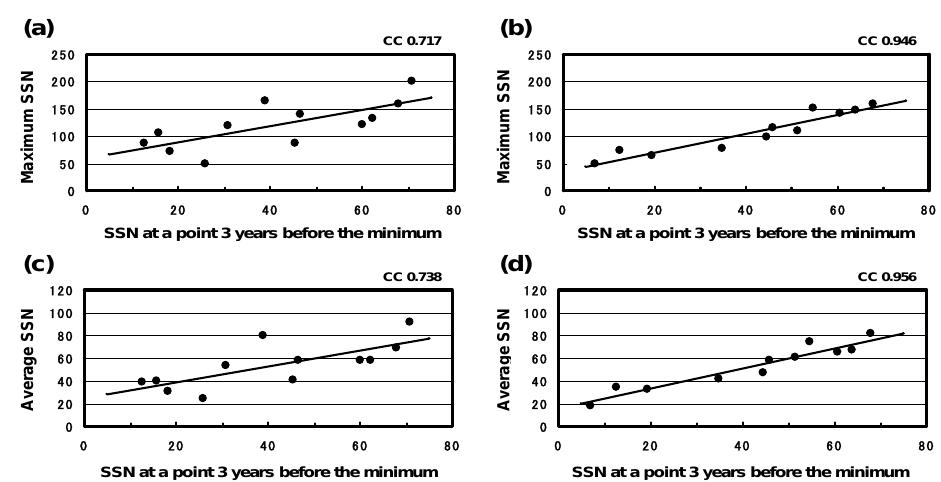
Figure 1. (a) Scatterplot of maximum SSN versus SSN 3 years before the minimum for odd-numbered cycles. (b) Same as panel (a) but for even-numbered cycles. The correlation coefficient and its lower and upper limits of the 95% confidence interval are 0.717, 0.243 and 0.921 for the former case, while those for the latter case are 0.946, 0.800 and 0.986, respectively. (c) Scatterplot of average SSN versus SSN 3 years before the minimum for odd-numbered cycles. (d) Same as panel (c) but for even-numbered cycles. The correlation coefficient and its lower and upper limits of the 95% confidence interval are 0.738, 0.284 and 0.915 for the former case, while those for the latter case are 0.956, 0.833 and 0.989,